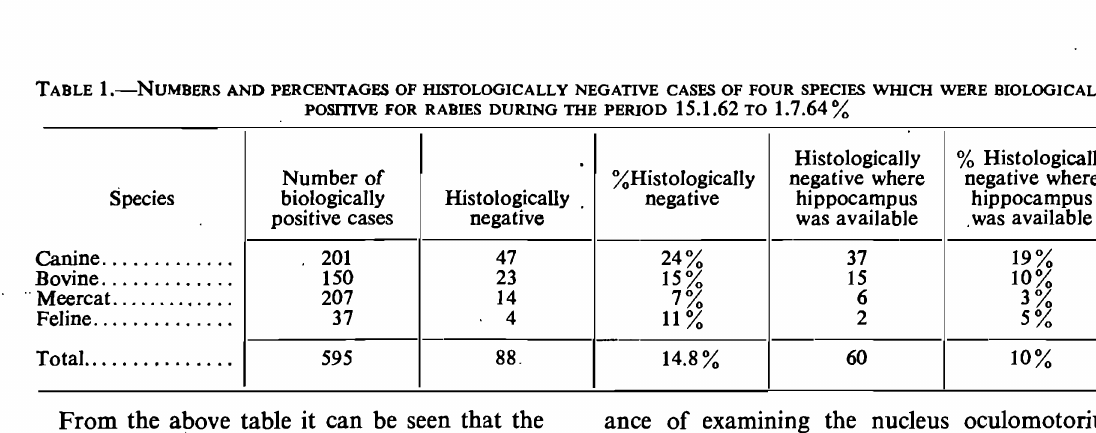
TABLE I.-NUMBERS AND PERCENTAGES OF HISTOLOGICALLY NEGATIVE CASES OF FOUR SPECIES WHICH WERE BIOLOGICALLY POSITIVE FOR RABIES DURING THE PERIOD 15.1.62 TO 1.7.64%